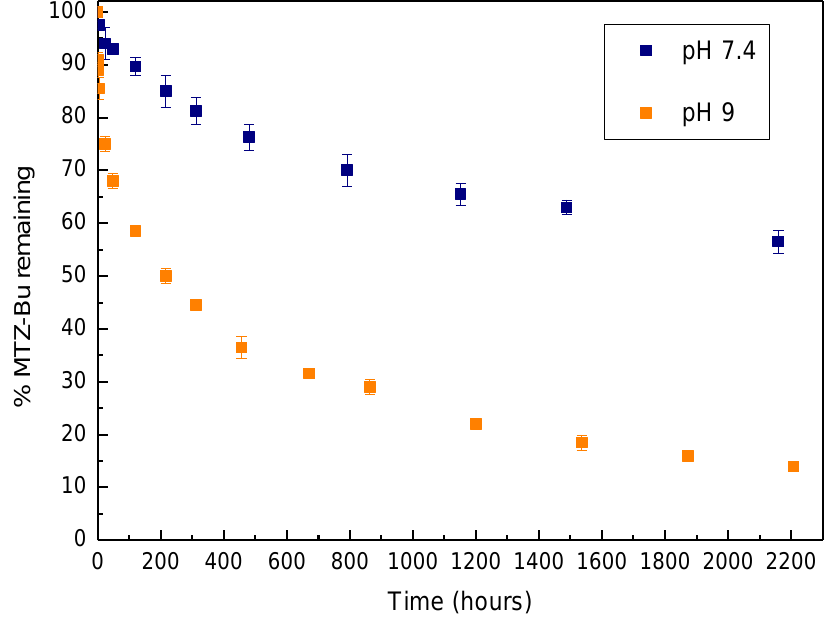
Figure 2. Degradation profile of the monomer MTZ-Bu at pH 7.4 and 9.